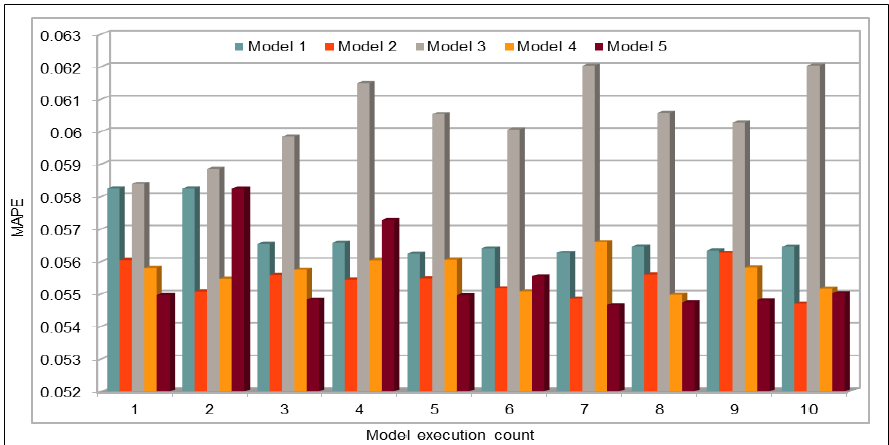
Figure 17. MAPE calculated by comparing actual and predicted vehicles flow on